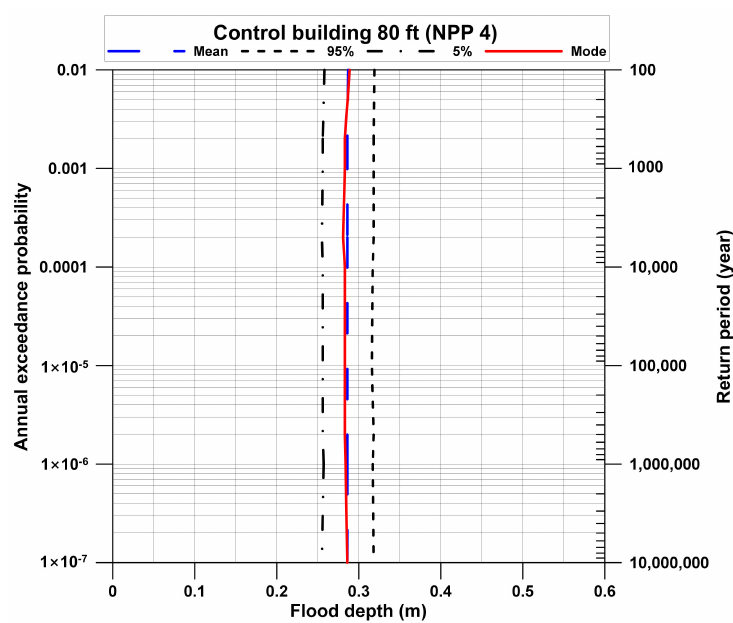
Figure 18. Probabilistic flood hazard curve for NPP